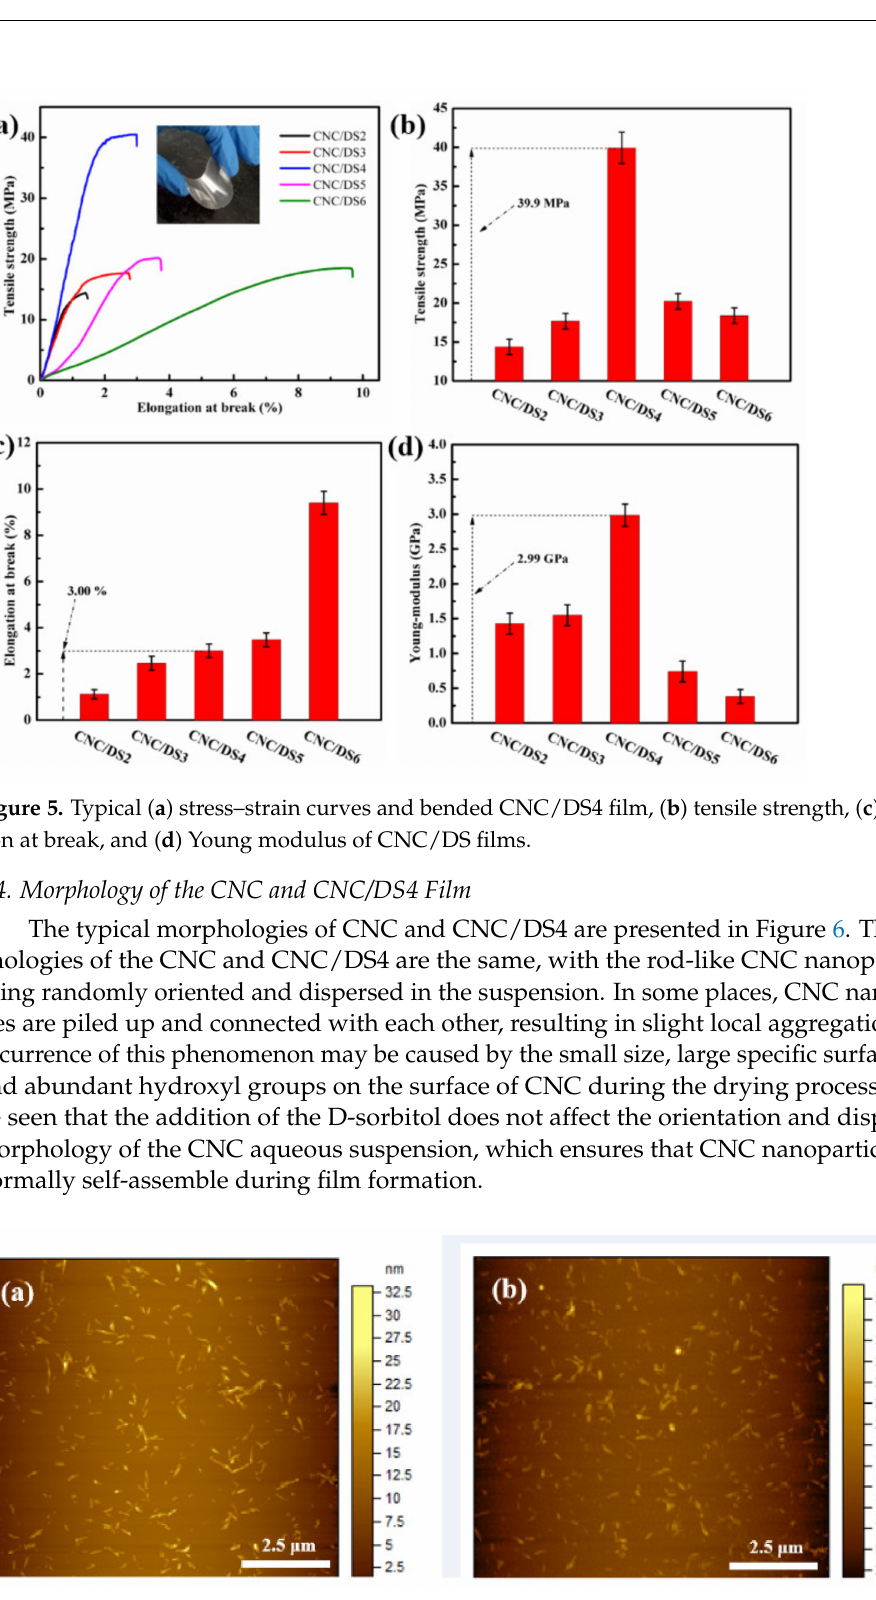
Figure 6. AFM images of the ( a ) pure CNC, ( b ) CNC/DS4 aqueous